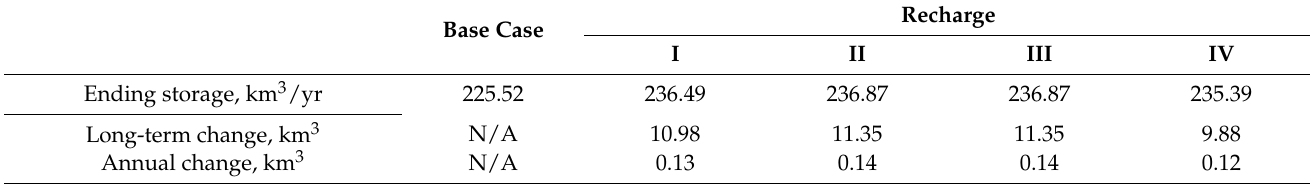
Table 6. Long-term change in groundwater storage over 82 years for different scenarios. Base